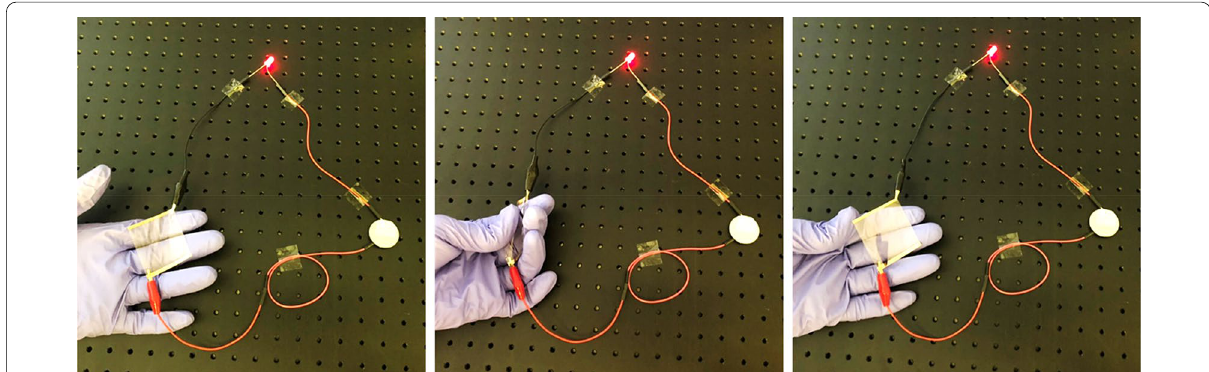
Fig. 4 Photographs of the 45 mm